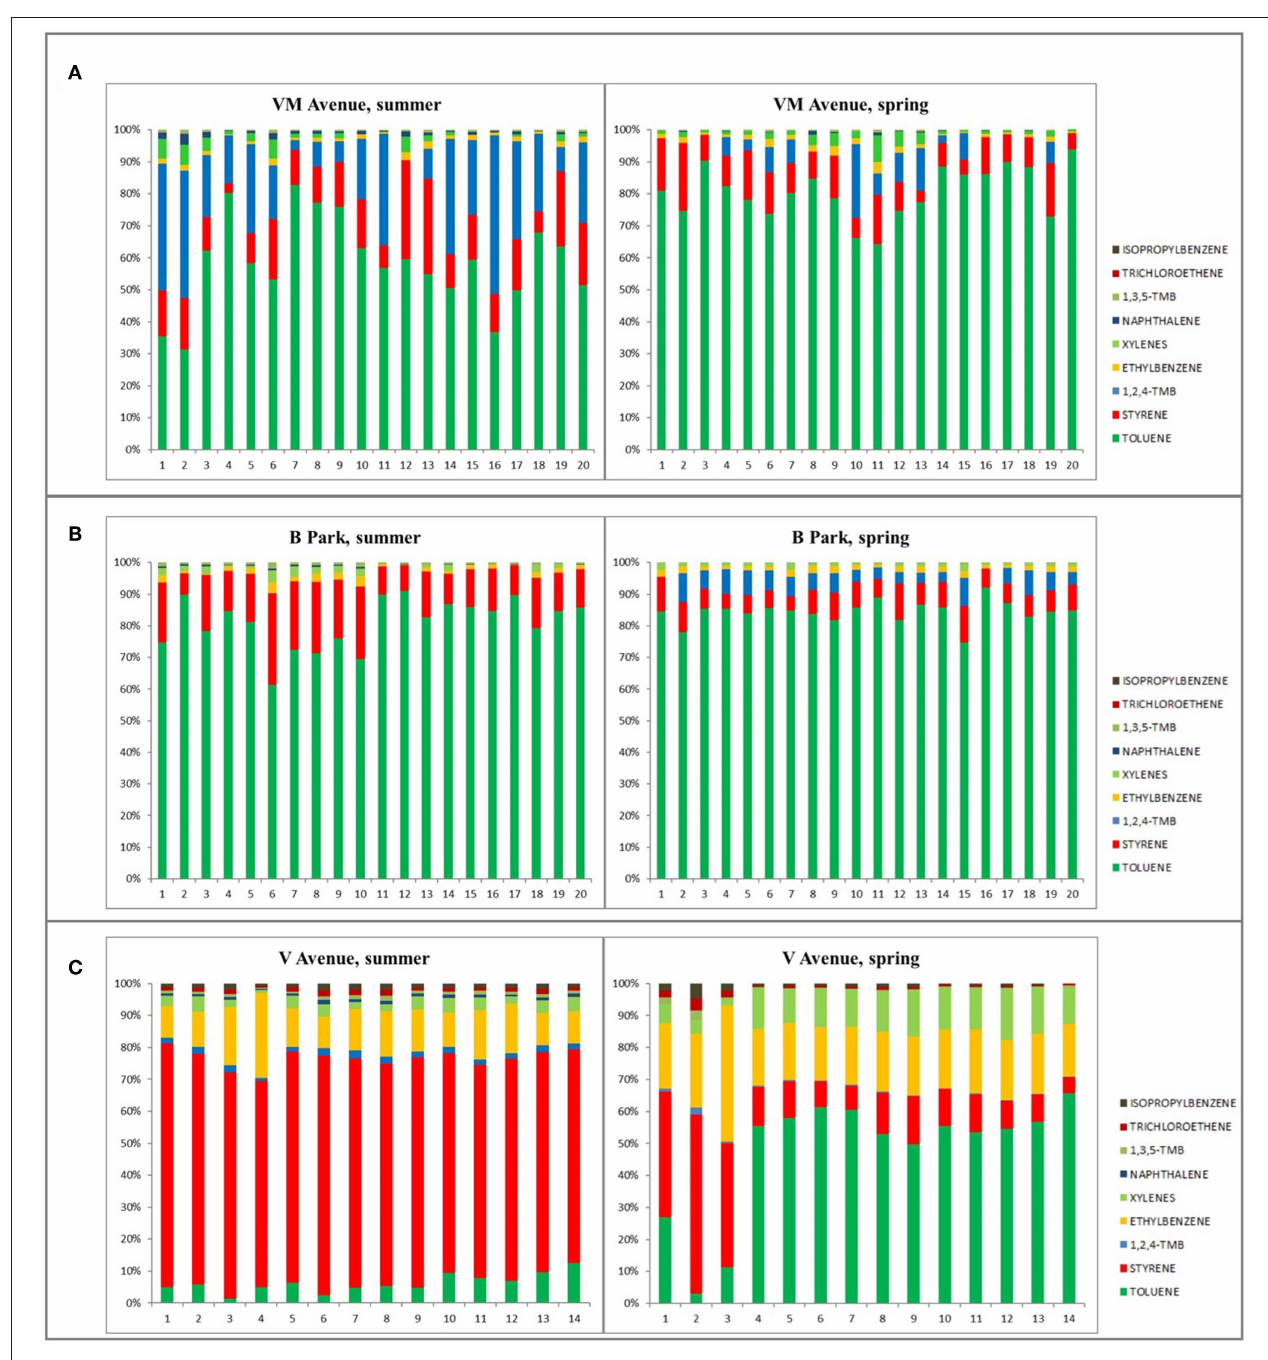
FIGURE 4 | Concentration profiles of AVOCs, in relative percentages, for each sampling site in summer and spring: (A) VM Avenue ( L. tulipifera ), (B) B Park ( L. tulipifera ), and (C) V Avenue ( Platanus sp ).